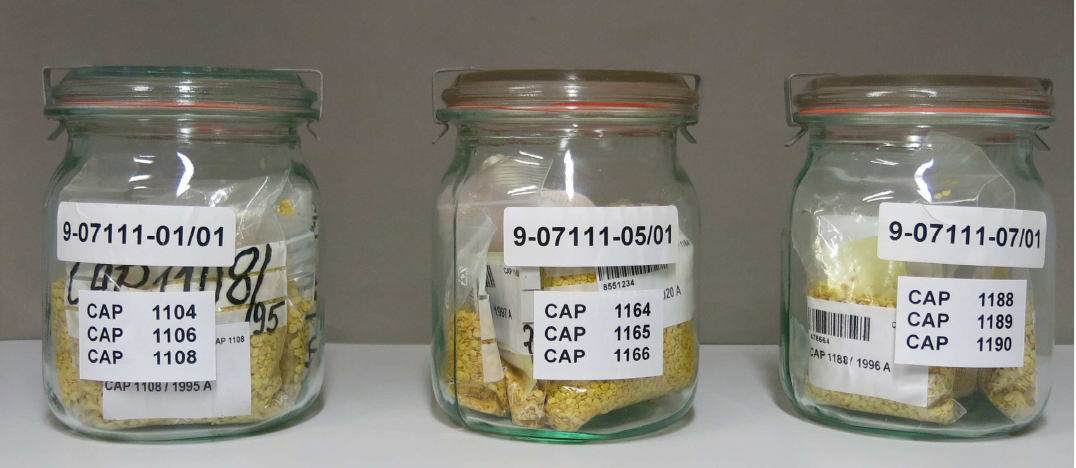
Figure 4. Storage of various Capsicum accessions [CAP1104, CAP1106, CAP1108, CAP1164, CAP1165, CAP1168, CAP1188, CAP1189 and CAP1190 (for details see Table S5) using the genebank ID number] in glass containers kept at below-freezing temperatures in the IPK genebank .